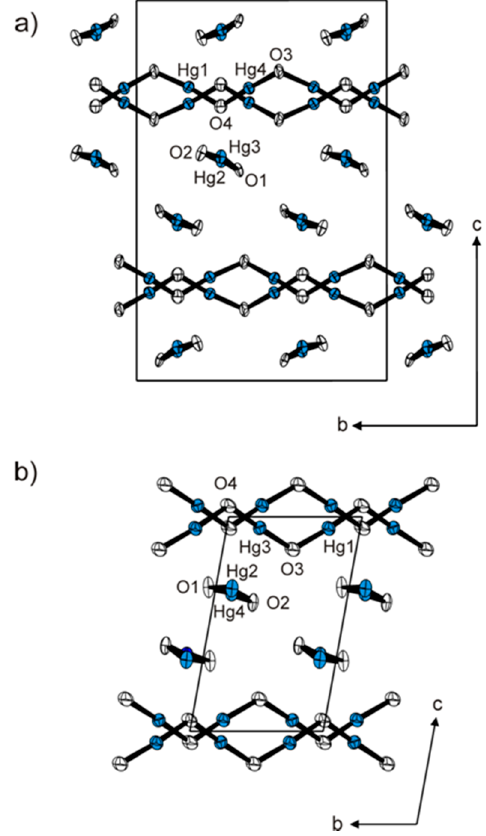
Figure 3. The two different Hg–O chains in the structures of ( a ) Cd(Hg II ) 4 O 4 (CrO 4 ) and ( b ) Figure Zn(Hg II ) 4 O 4 (CrO 4 ). Displacement ellipsoids are drawn at the 90% probability level.